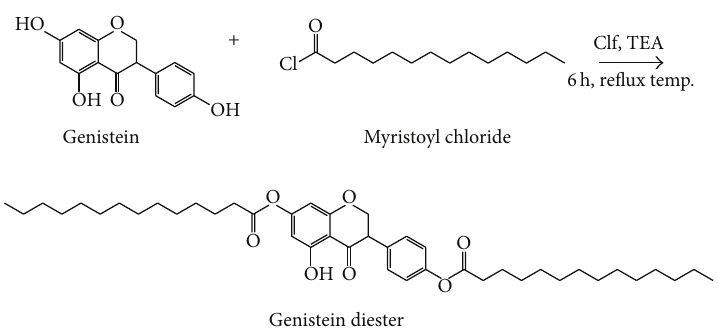
Figure 1: Chemical esterification of genistein using myristoyl chloride, in chloroform (Clf) media, in the presence of triethylamine (TEA), for 6 hours at reflux temperature. The solvent was removed by evaporation and the products were further purified by column chromatography thus achieving a highly pure genistein ester (GMAE) in 34–39%